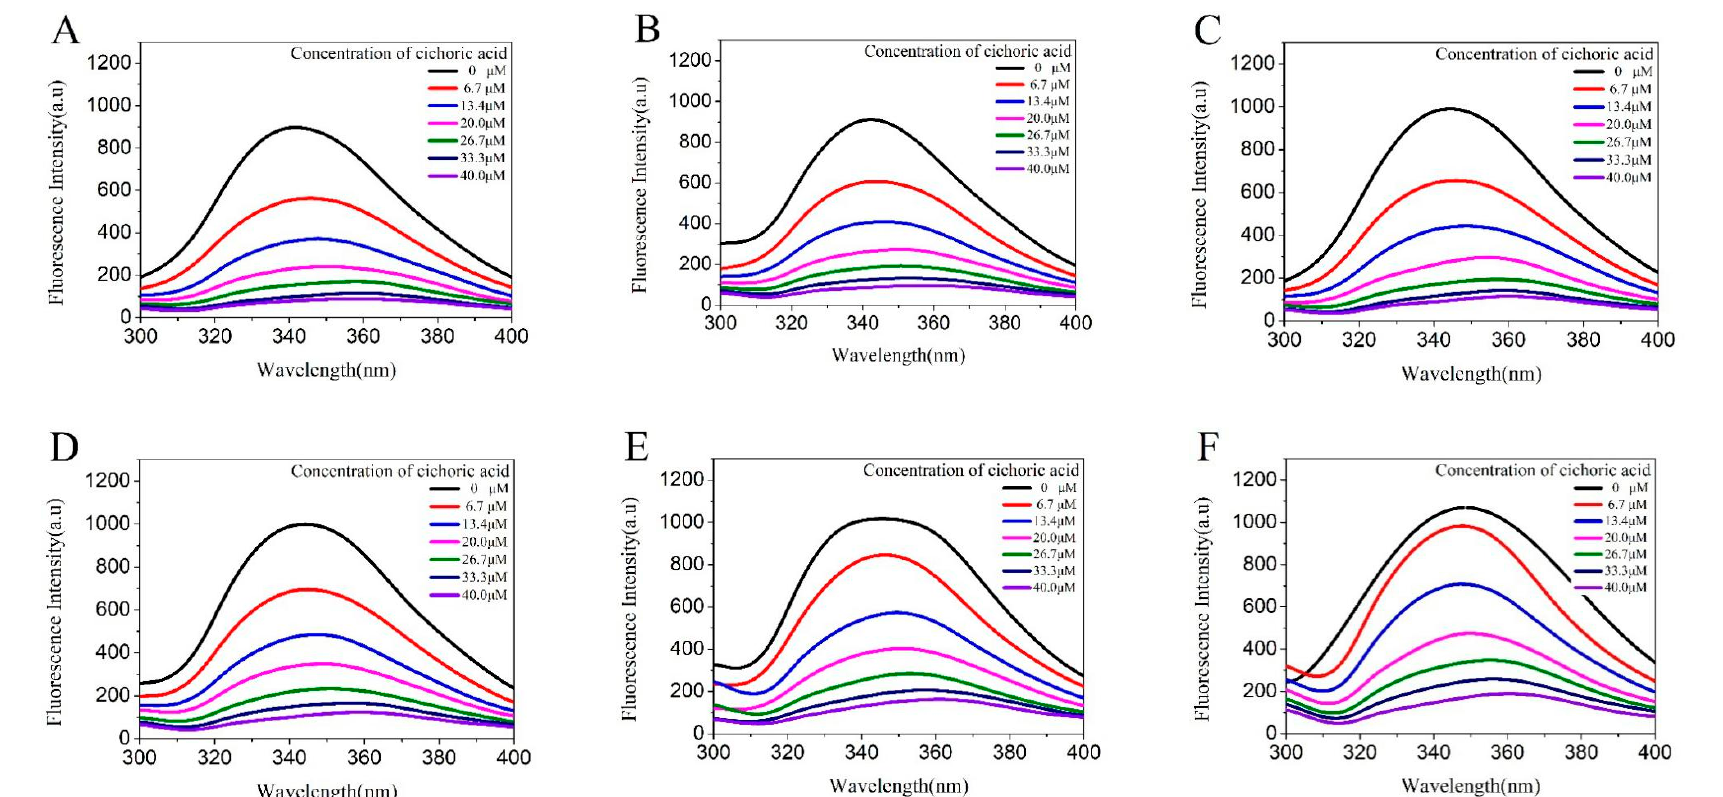
Figure 1. Fluorescence emission spectra of 0.025 M LF at pH 4.0 (curve A – C ) and pH 7.0 (curve D – F ) in the presence of CA with concentrations in the range of 0 to 40 μ M upon excitation at 295 nm, and ( A , D ) were at 25 °C, ( B , E ) were at 70 °C, ( C , F ) were at 95 °C.